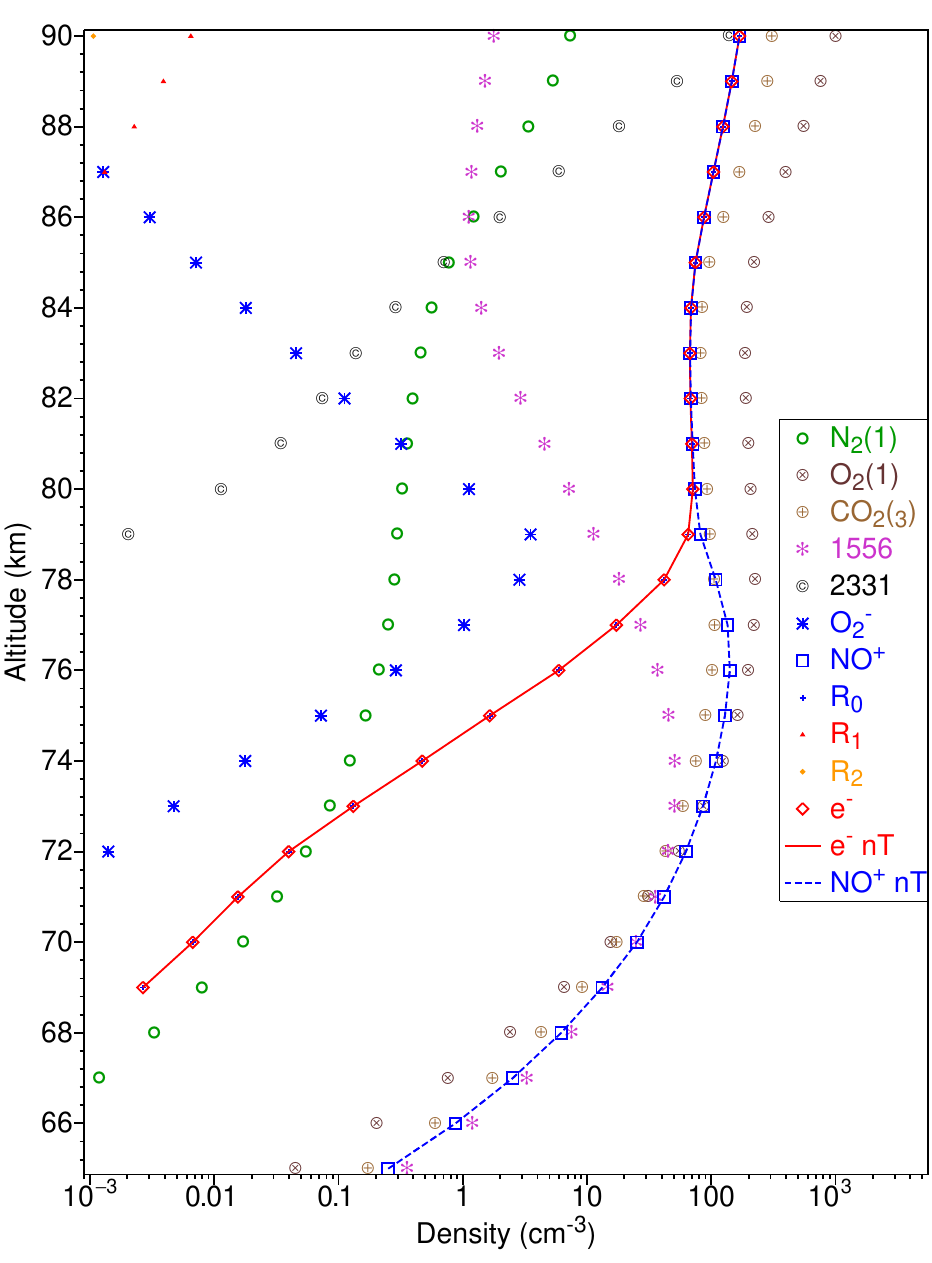
Figure 8. Calculated densities as a function of altitude: electron (—) and NO + (- - -) densities for the nT method; densities for electrons ( ♦ ), NO + ( (cid:3) ), molecules, electron subranges and emitted photons as labelled for the EI method with elastic scattering